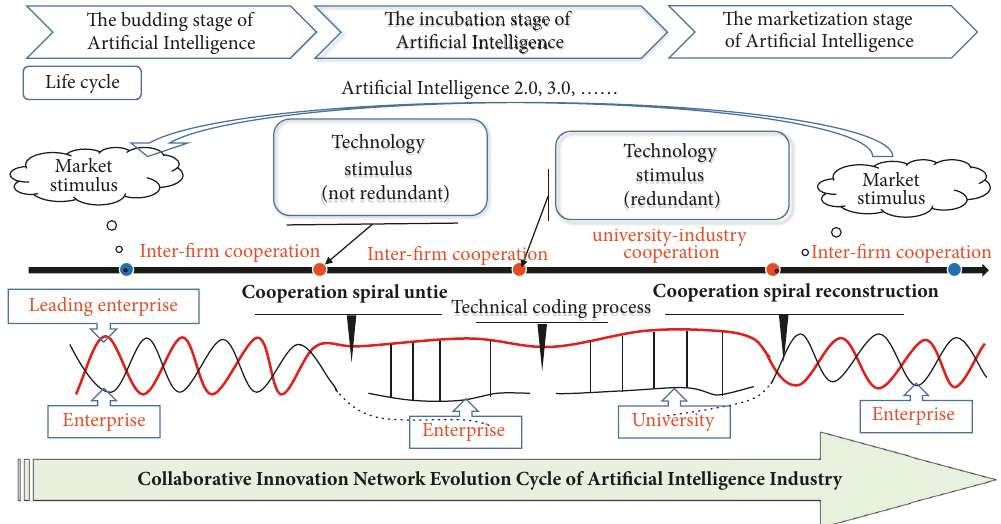
Figure 3: Collaborative innovation network evolution conceptual model of AI